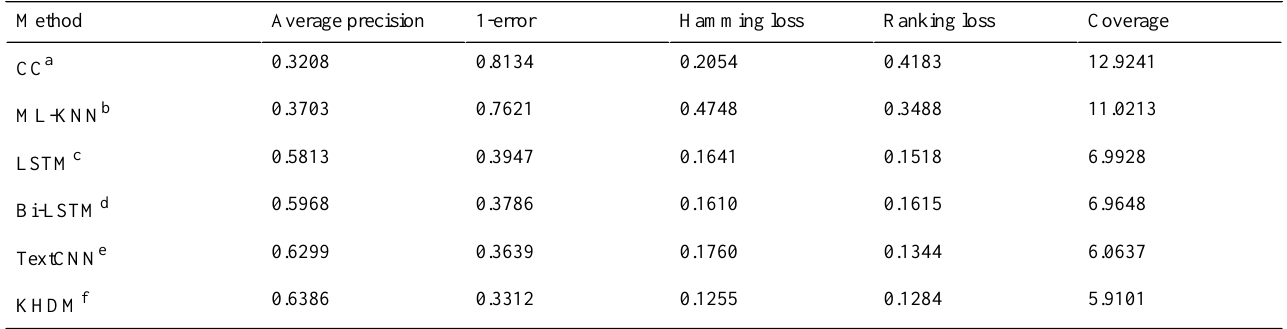
Table 3. Comparative results on public dataset DeliciousMIL.